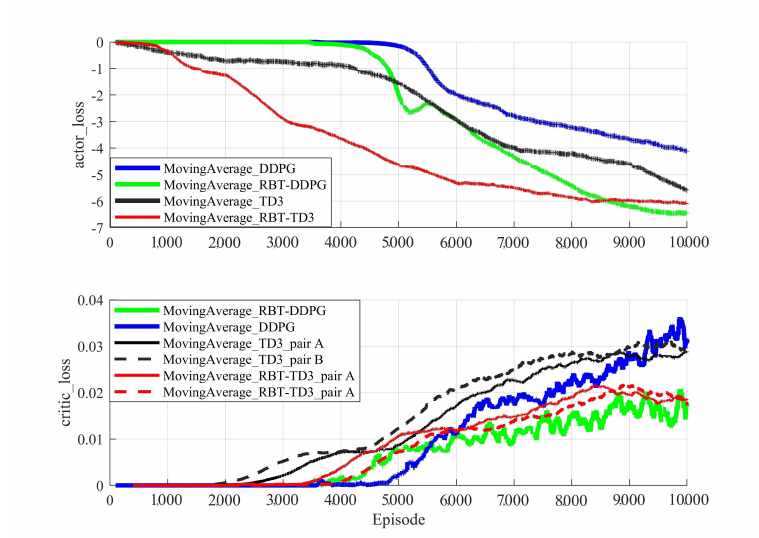
Figure 5. Loss function of AN and CN during training. Similar to the cumulative reward curve presented in Figure 4, the actor loss function of RBT-DDPG in Figure 5 decreases faster, indicating that RBT-DDPG ensures that AN learns faster. RBT-DDPG has a lower CN loss function almost throughout the episodes, reflecting that RBT can improve the CN estimation. The same phenomenon occurs in the comparison between RBT-TD3 and its original version.